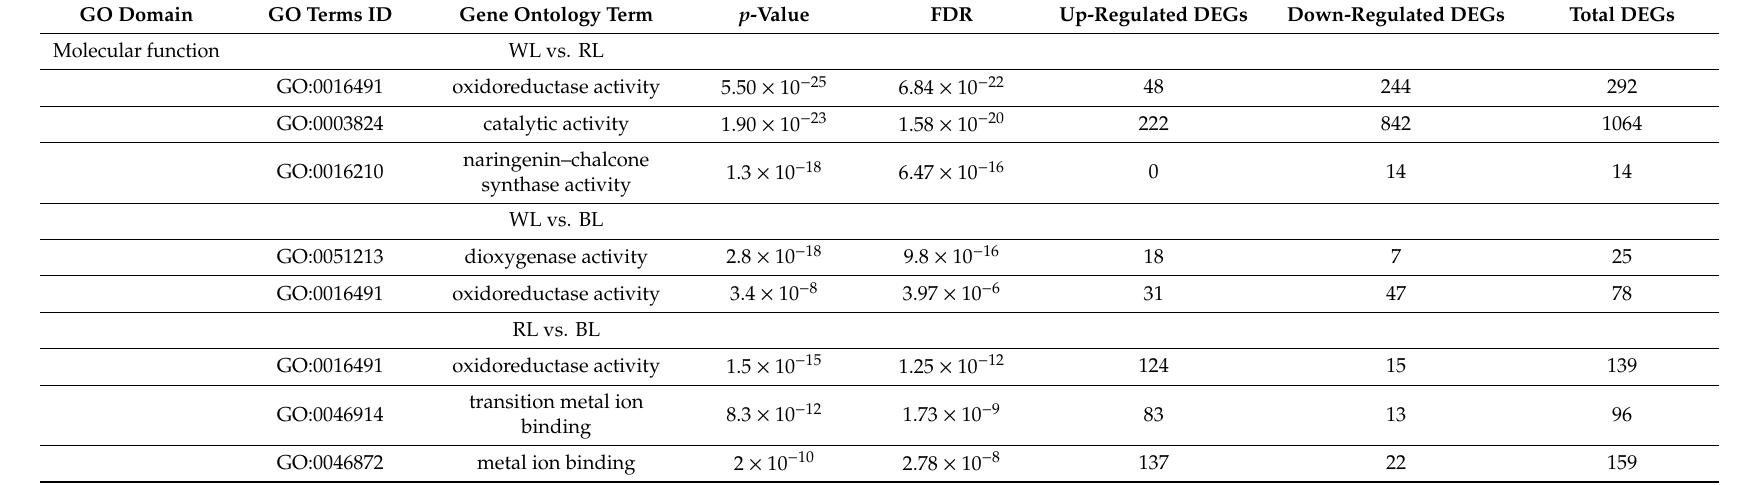
Table 3. Molecular function enrichment analyses for DEGs between di ff erent light